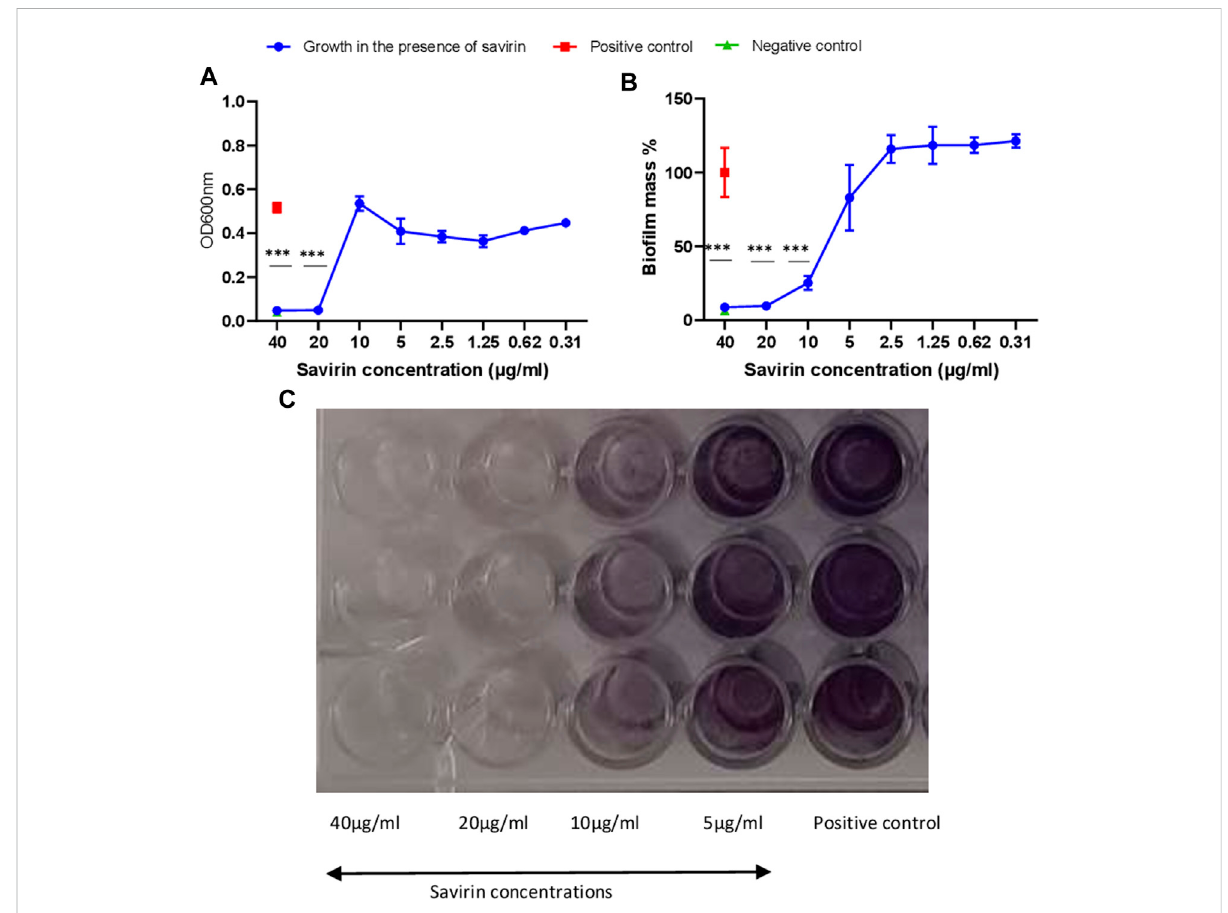
FIGURE 1 Planktonic (A) and bio fi lm (B,C) growth of S. aureus in the presence of different savirin concentrations. Triplicate wells were used for each treatment (N = 3) and experiments were repeated twice. Data are presented as mean ± standard deviation (SD) and the error bars indicate SD (*** = p <